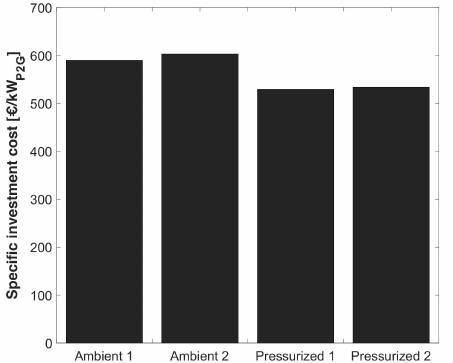
Figure 8. Maximum allowed specific investment cost for the P2G configurations, with a target SNG production cost ( p SNG = 63.226 EUR/MWh), with ratio between the P2G power size and the renewable generation peak power equal to 1/1.7 and without carbon tax